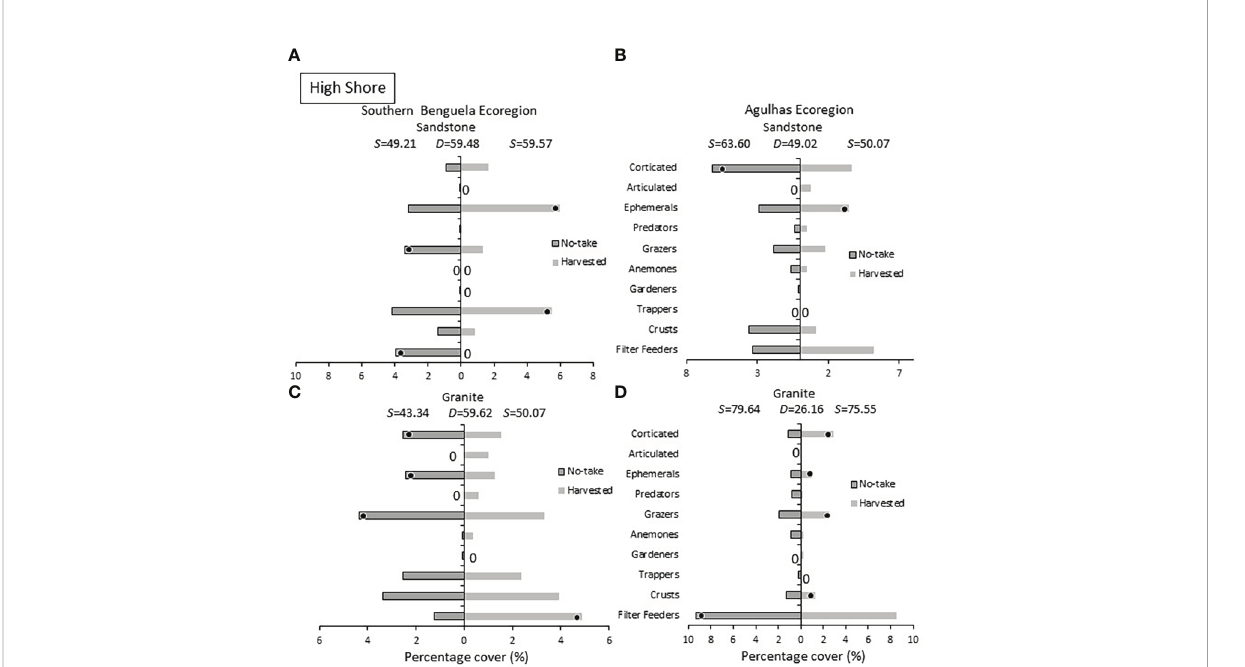
FIGURE 8 High shore: Percentage cover of groups responsible for similarities ( S ) within harvested or no-take areas and dissimilarities ( D ) between them, on (A) sandstone in the Southern Benguela and (B) Agulhas ecoregions, and on granite in (C) the southern Benguela and (D) Agulhas. See caption for Figure 6 for further